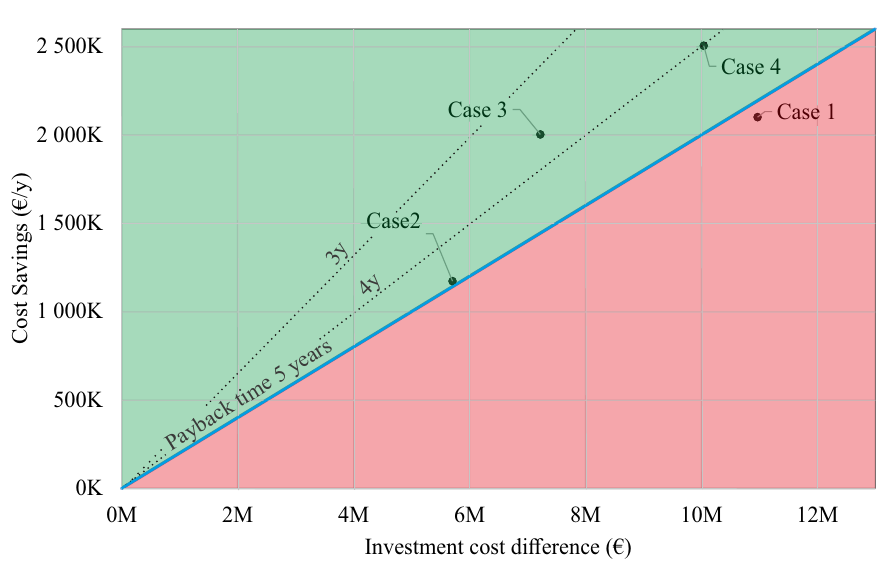
Figure 10. Cost savings per year over investment cost difference between conventional HEN and extended HEN results. In the green area the payback time is shorter than 5 years and in the red area the payback time is longer than 5